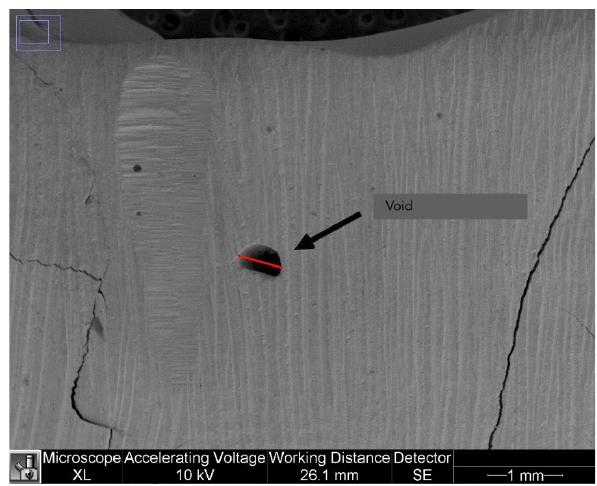
Figure 4. A void on a 40× image.